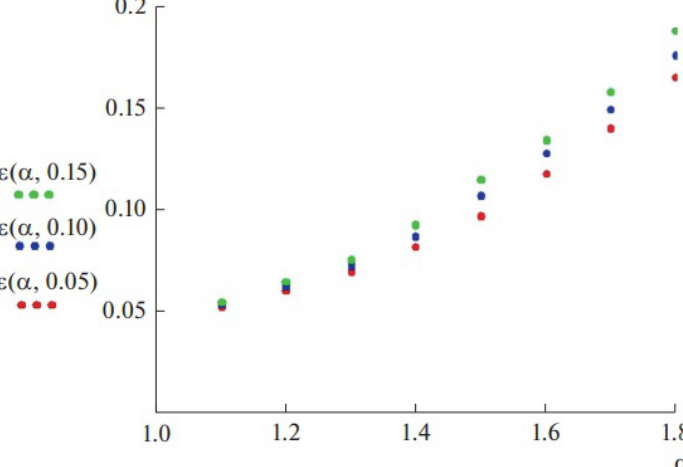
Figure 2. On the question of the sensitivity of the solutions of Problem (31) to errors of the Figure 2. On question of sensitivity of solutions of problem (31) to errors of parameter.